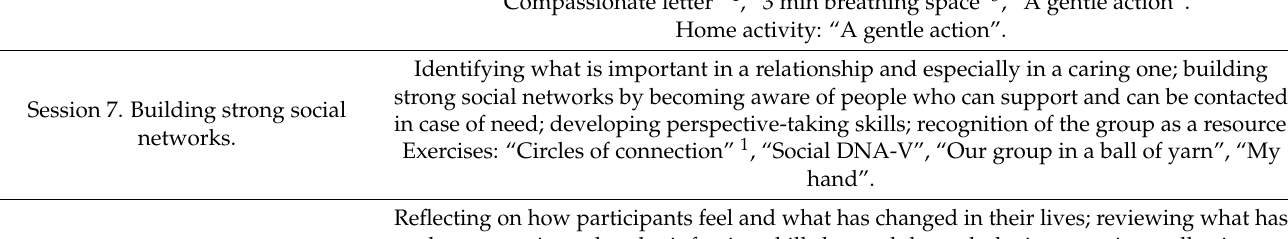
Session 6. Developing a flexible self-view and self-compassion.